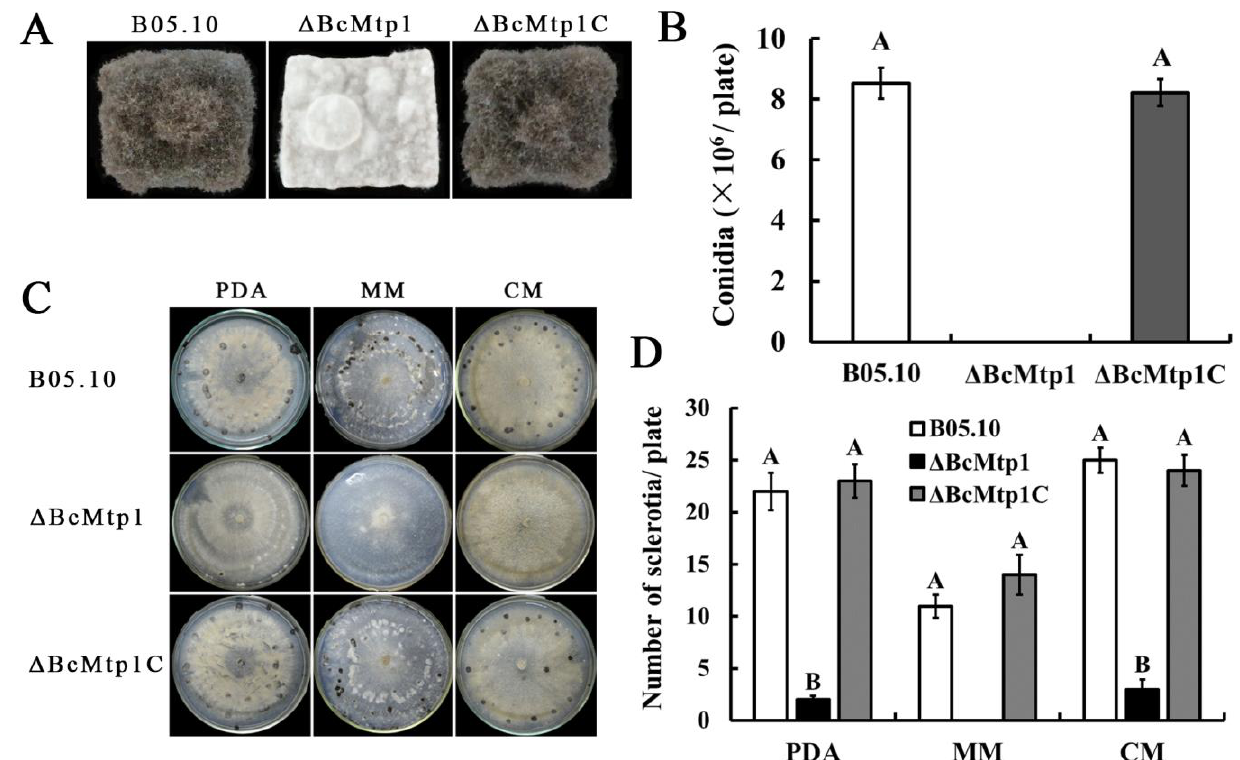
Figure 2. Function of BcMtp1 on conidial and sclerotial formation. ( A ) Comparison of conidiation among B05.10, ΔBcMtp1 , and ΔBcMtp1C after 12 d incubation on sterilized potato plugs at 25 °C in dark. ( B ) The number of conidia produced by each strain on potato dextrose agar (PDA) plates (diameter, 9 cm). Bars denote standard deviation from three experiments. Values on the bars followed by the same letter are not significantly different at p = 0.05. ( C ) Comparison of sclerotial formation among B05.10, ΔBc Mtp1 , and ΔBcMtp1C after 4 weeks of incubation on PDA, complete medium (CM) and minimal medium (MM) at 25 ℃, in darkness. ( D ) The number of sclerotia was measured on PDA, CM, and MM. Bars denote standard deviation from three experiments. Values on the bars followed by the same letter are not significantly different at p = 0.05.